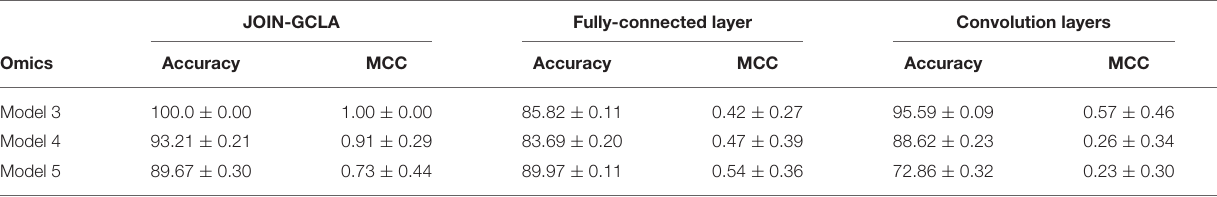
TABLE 8 | Ablation study of the connectome encoder on DTI-fMRI dataset.